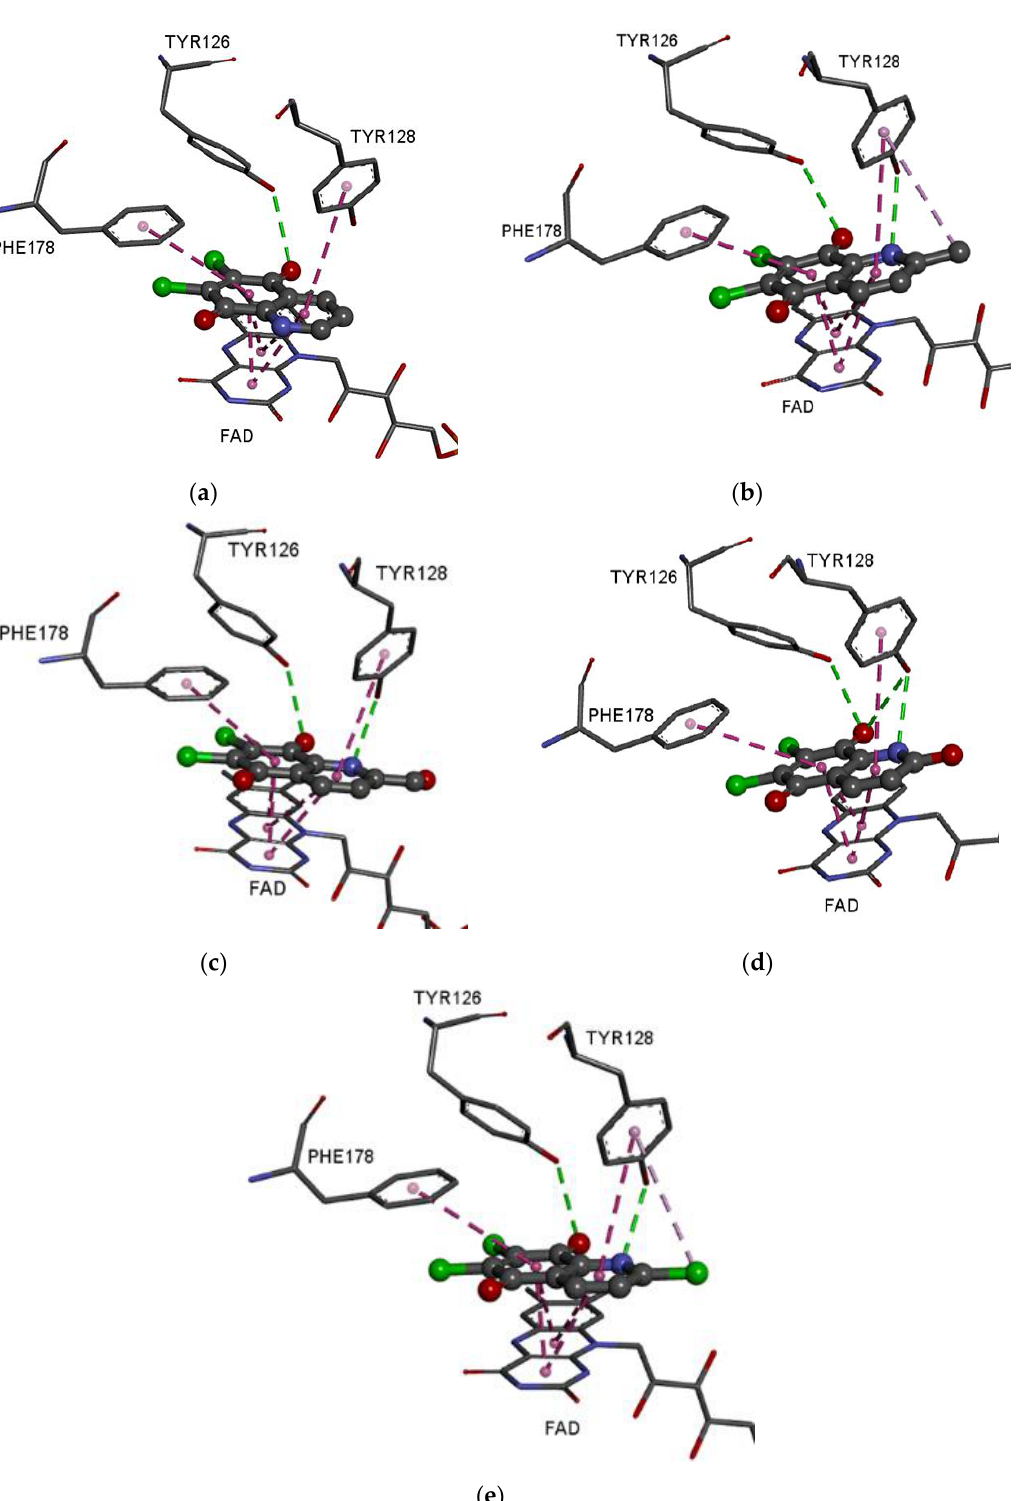
Figure 6. Visualization of interactions between the NQO1 enzyme and derivatives: ( a ) 1 , ( b ) 2 , ( c ) 3 , ( d ) 6 , ( e ) 7 . 6,7-Dichloro-5,8-quinolinedione 1 creates the hydrogen bond between the formyl group at the C8 position and tyrosine (TYR126) as well as hydrophobic interactions with phenylalanine (PHE178), tyrosine (TYR128), and the FAD cofactor. Molecules with a substituent at the C2 position ( 2 – 3 and 6 – 7 ) create also the hydrogen bond between nitrogen atom and tyrosine (TYR126). Additionally, in the complex of 6,7-dichloro-2-hydroxy-5,8- quinolinedione 6 with NQO1, a hydrogen bond is observed between the formyl group at the C8 position and tyrosine (TYR126). 4. Conclusions Research has shown that the new derivatives of 6,7-dichloro-5,8-quinolinedione are characterized by a number of properties that can be important for their biological activity. The quantum chemical properties showed that they are highly reactive towards the nu- cleophilic target. The in silico ADMET analysis showed that compounds are characterized by a good oral availability and low toxicity against fathead minnows . The enzymatic study showed that they are a good substrate for the NQO1 enzyme. Moreover, it was also found that the enzymatic conversion rates depend on the type of substituent at the C2 position of the 5,8-quinolinedione scaffold. A compound with the substituted hydroxyl group at this position exhibited the highest activity. A molecular docking study revealed that the